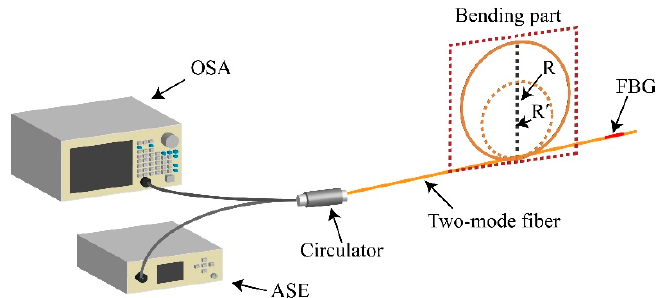
Figure 8. Schematic diagram of the two-mode FBG bending experiment.